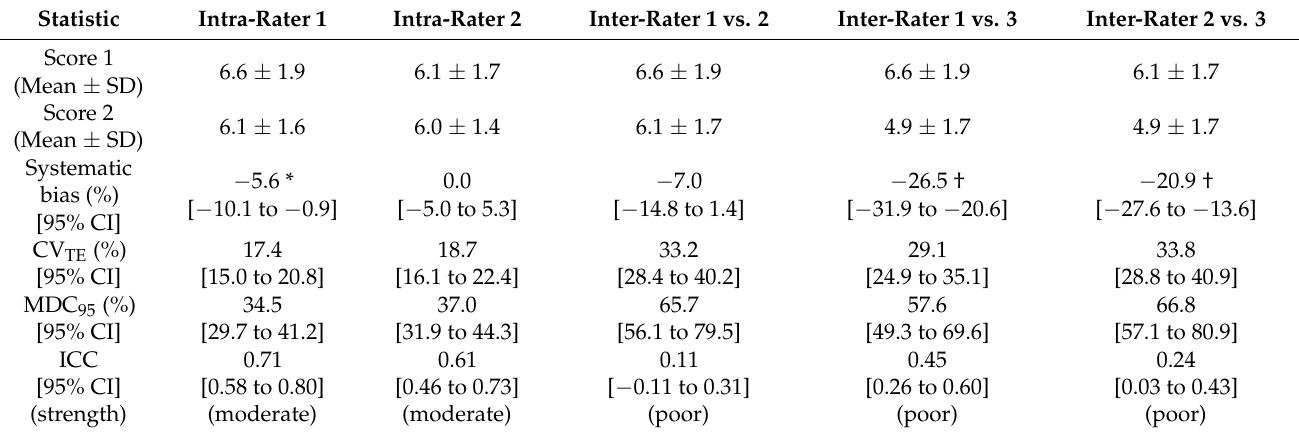
Table 2. Intra-rater and inter-rater reliability of the CMAS score ( n = 61 cases). Intra-Rater 1 Intra-Rater 2 Inter-Rater 1 vs. 2 Inter-Rater 1 vs. 3 Inter-Rater 2 vs.